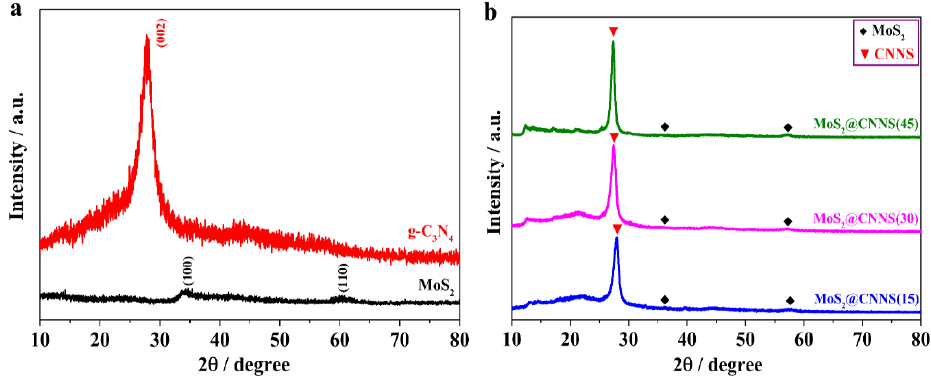
Figure 1. XRD patterns of MoS 2 QDs and g-C 3 N 4 ( a ) and MoS 2 @CNNS nanocomposites ( b ).